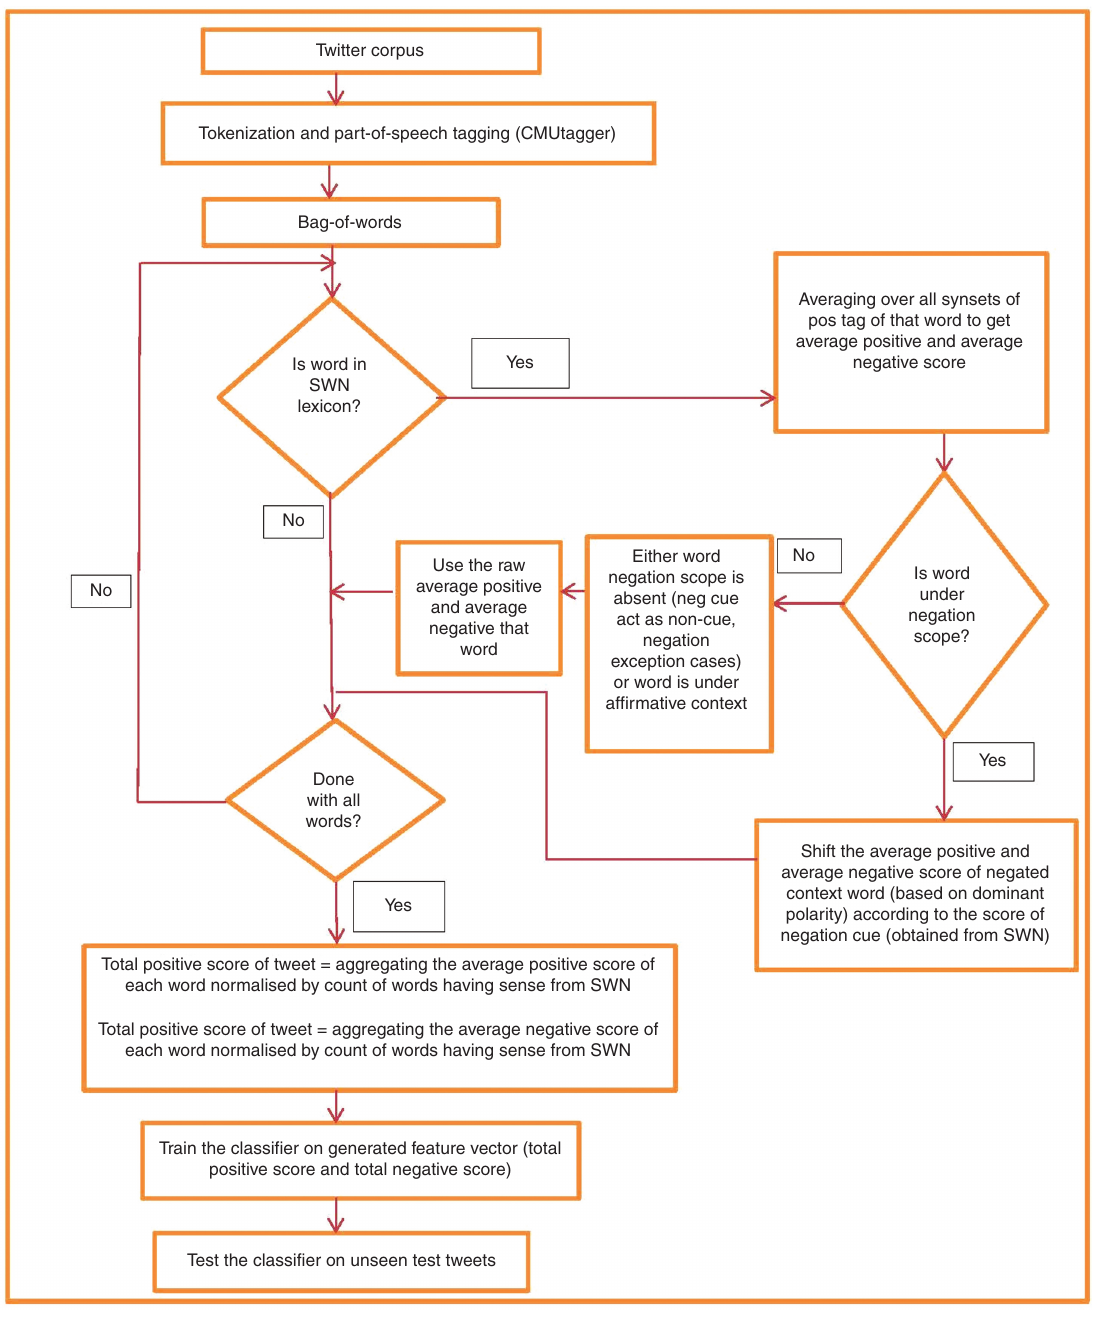
Figure 1: The Overall Workflow of our Proposed Hybrid Framework.